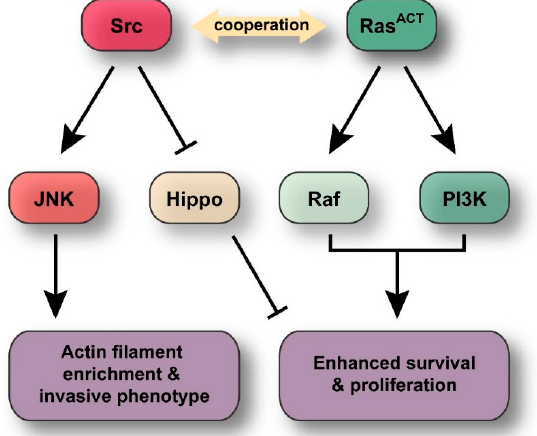
Figure 9. Model for the cooperation of Src and oncogenic Ras in tumourigenesis. Coexpression of Src and oncogenic Ras (Ras V12/ACT ) results in cooperative tumourigenesis in Drosophila epithelia, resulting in invasive, overgrown tumours characterised by loss of differentiation and F-actin accumulation. Upon Src expression, JNK pathway signalling is activated and the Hippo pathway is inhibited, whilst downstream of oncogenic Ras, activation of Raf and PI3K is required for cooperative tumourigenesis with Src.